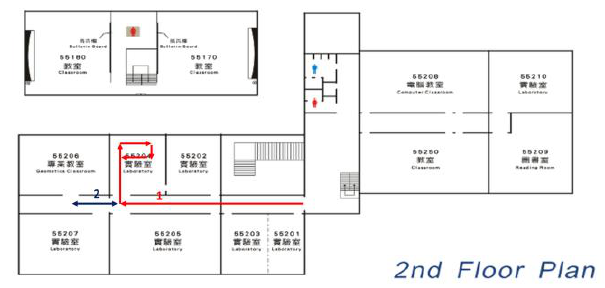
Figure 5. The floor plan of experimental